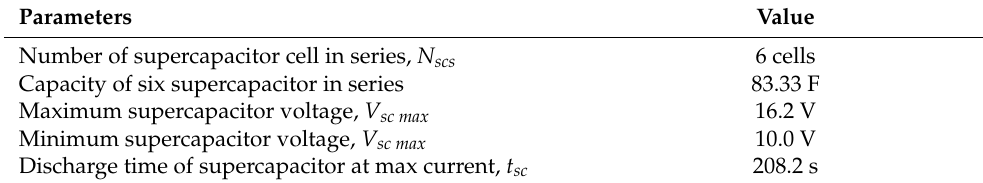
Table 6. Parameters for